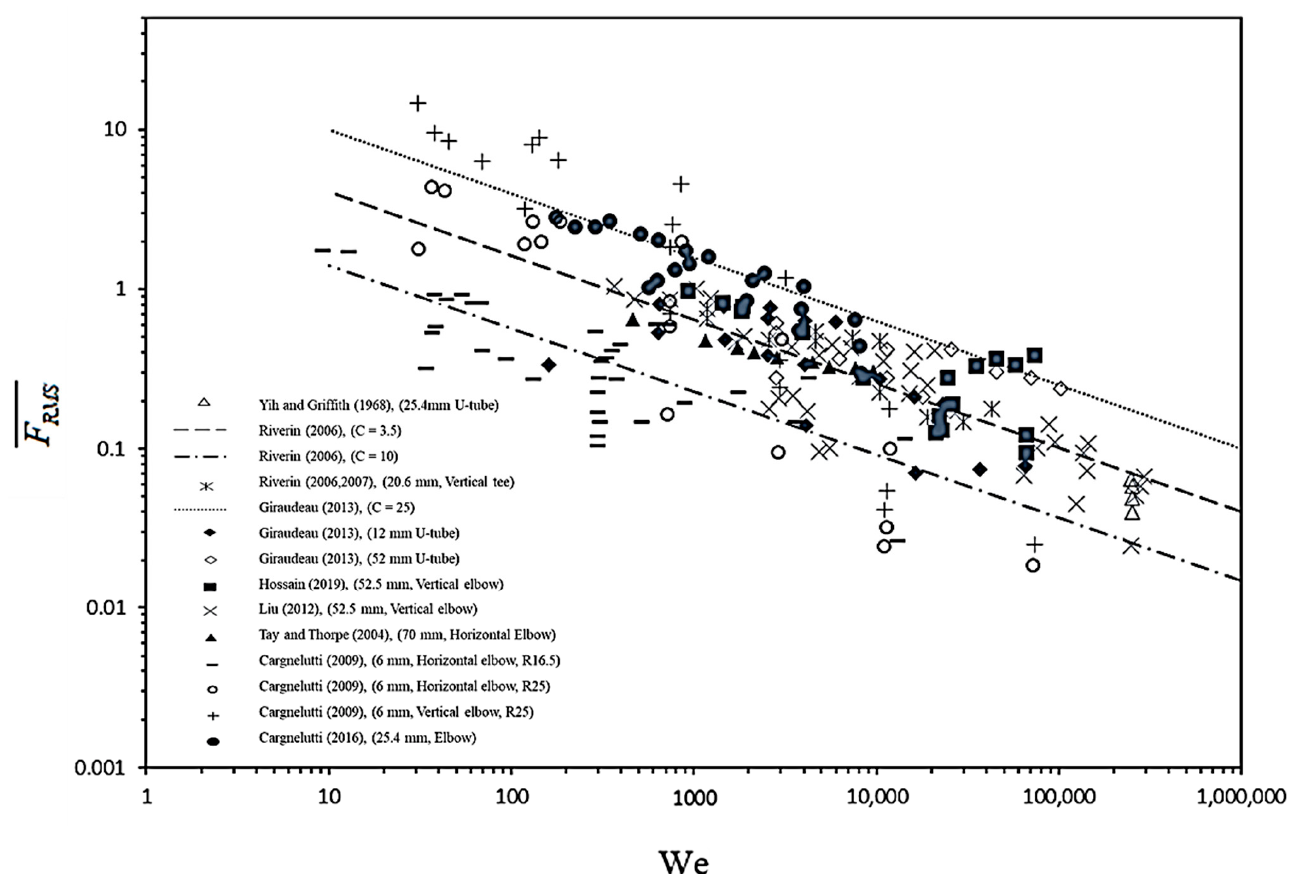
Figure 6. Comparison of dimensionless forces plotted against the Weber number [8,48,63– 66,73,76,77].